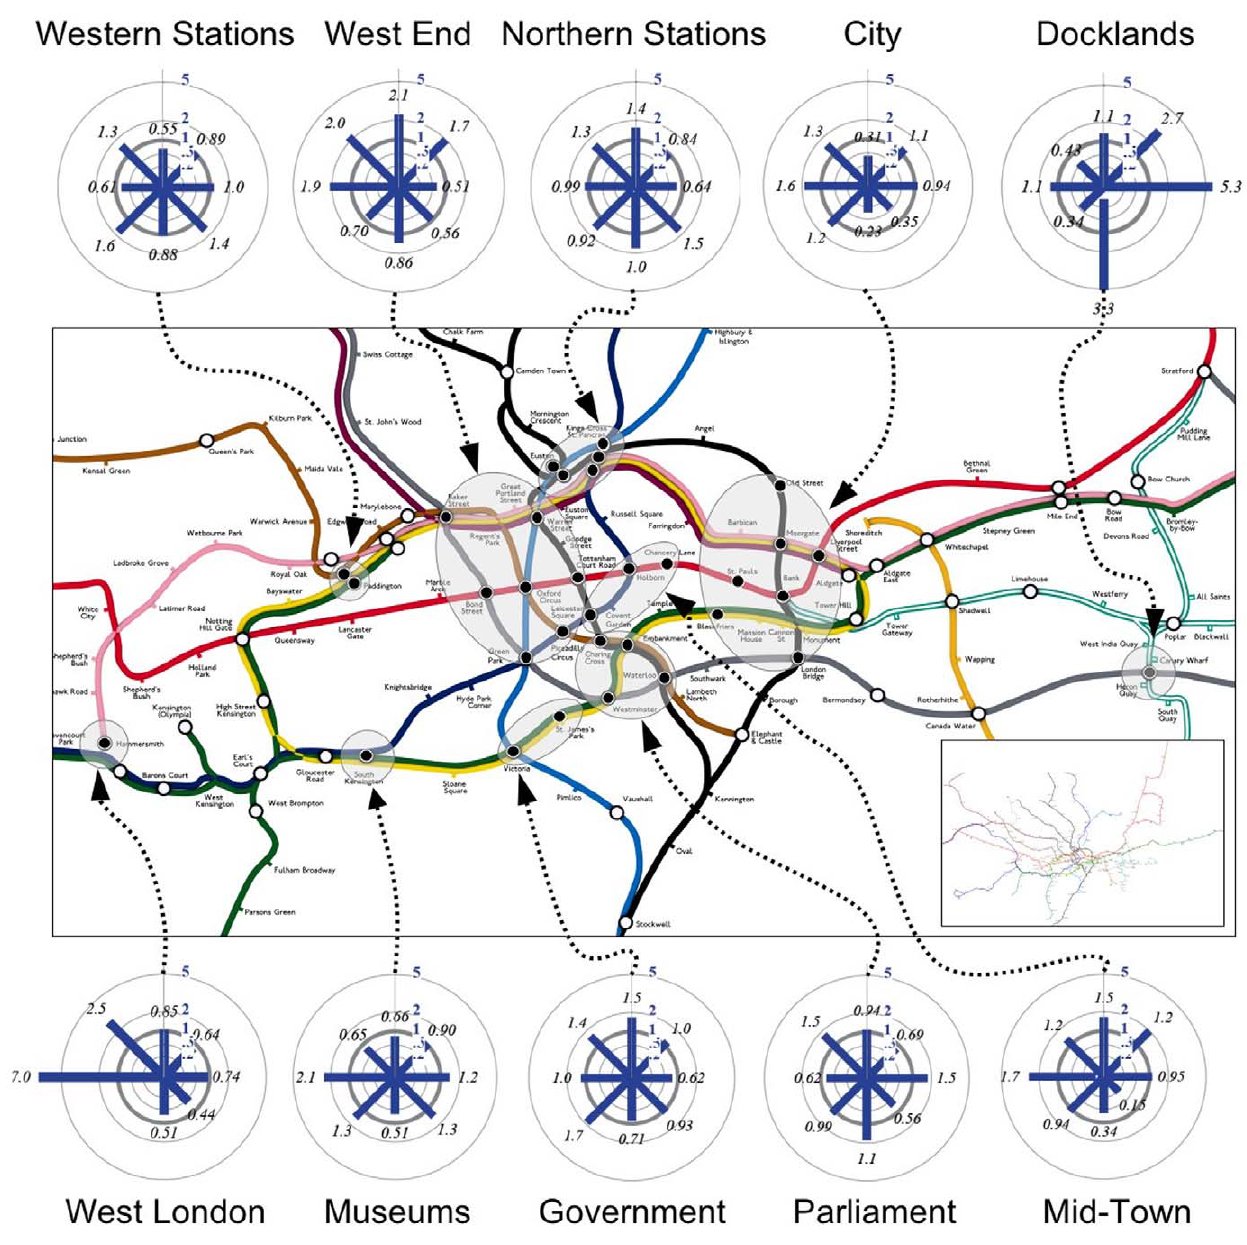
Figure 5. The London subway (tube) system: polycenters and basins of attraction. In the inset, we show the entire tube network while in the main figure, we zoom in on the central part of London. We represent the ten most important polycenters defined in the dendrogram of Figure 3, and show the corresponding propensity to anisotropy comparing actual flows with the null model defined in the text. A propensity of 1 means that there is no deviation in a given direction with respect to the null model. Circles correspond to various levels of identical propensity values: the thicker circle in the middle corresponds to 1 , inner circles correspond to propensities of 0 : 2 and 0 : 5 , and outer circles to 2 and 5 . The anisotropy is essentially in opposite directions from the center, thus showing a strong bias towards the suburbs for peripheral centers essentially, rather than for central centers. Moreover, most stations control their own regions and seem to have their own distinctive basins of attraction.